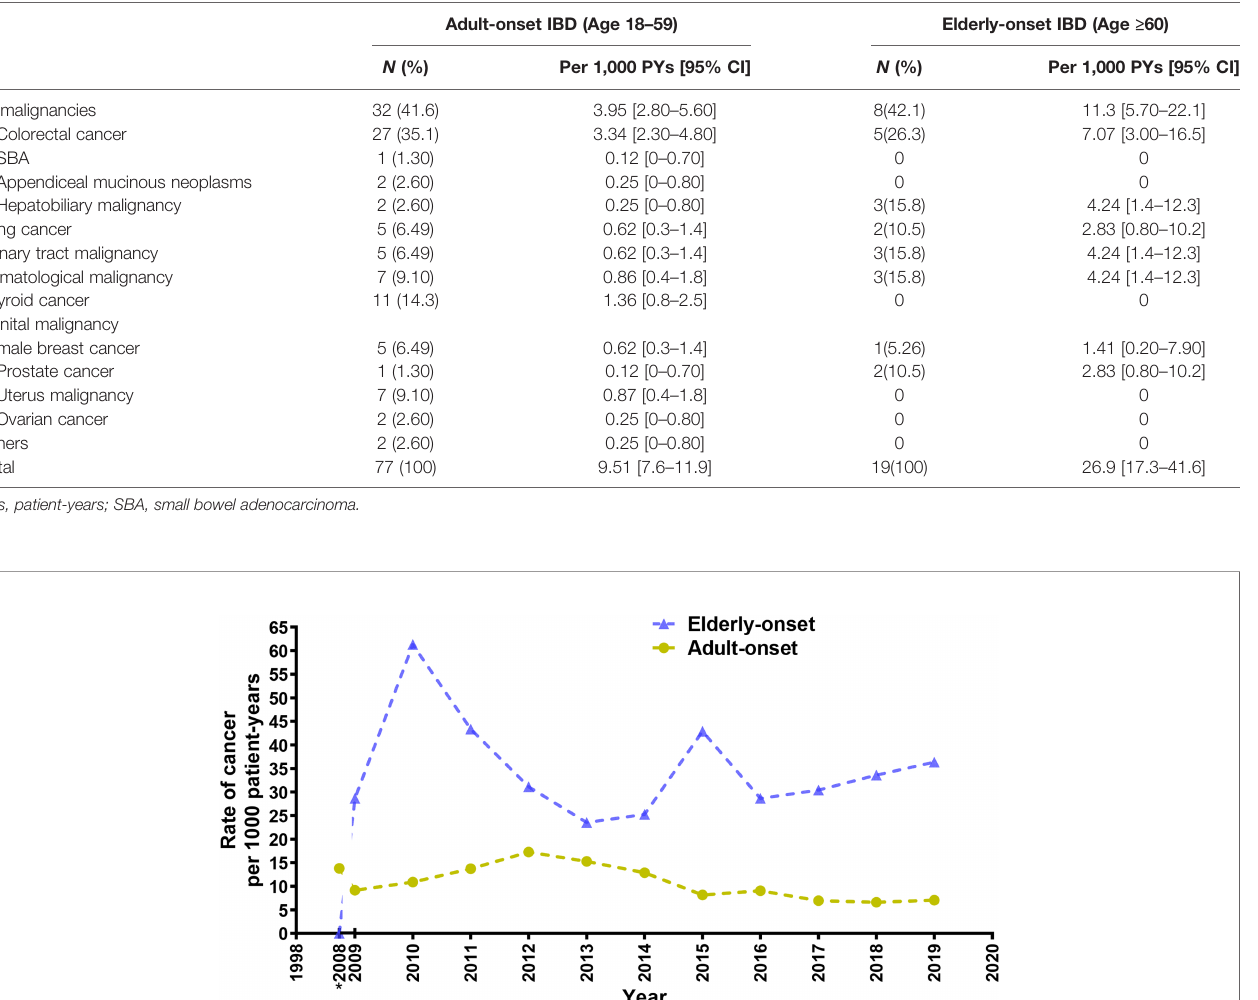
TABLE 2 | Distribution and incidence rates of malignancy among adult-onset and elderly-onset